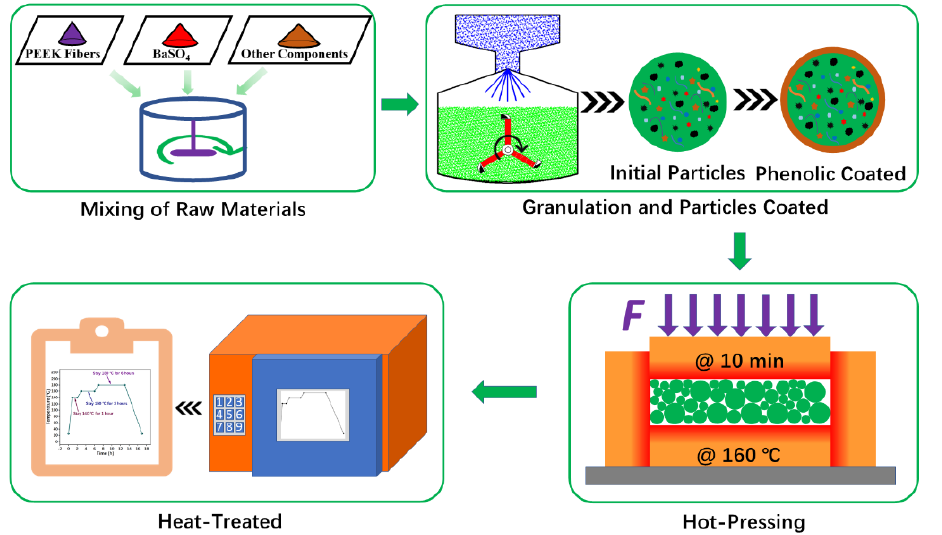
Figure 1. The fabrication process of specimens